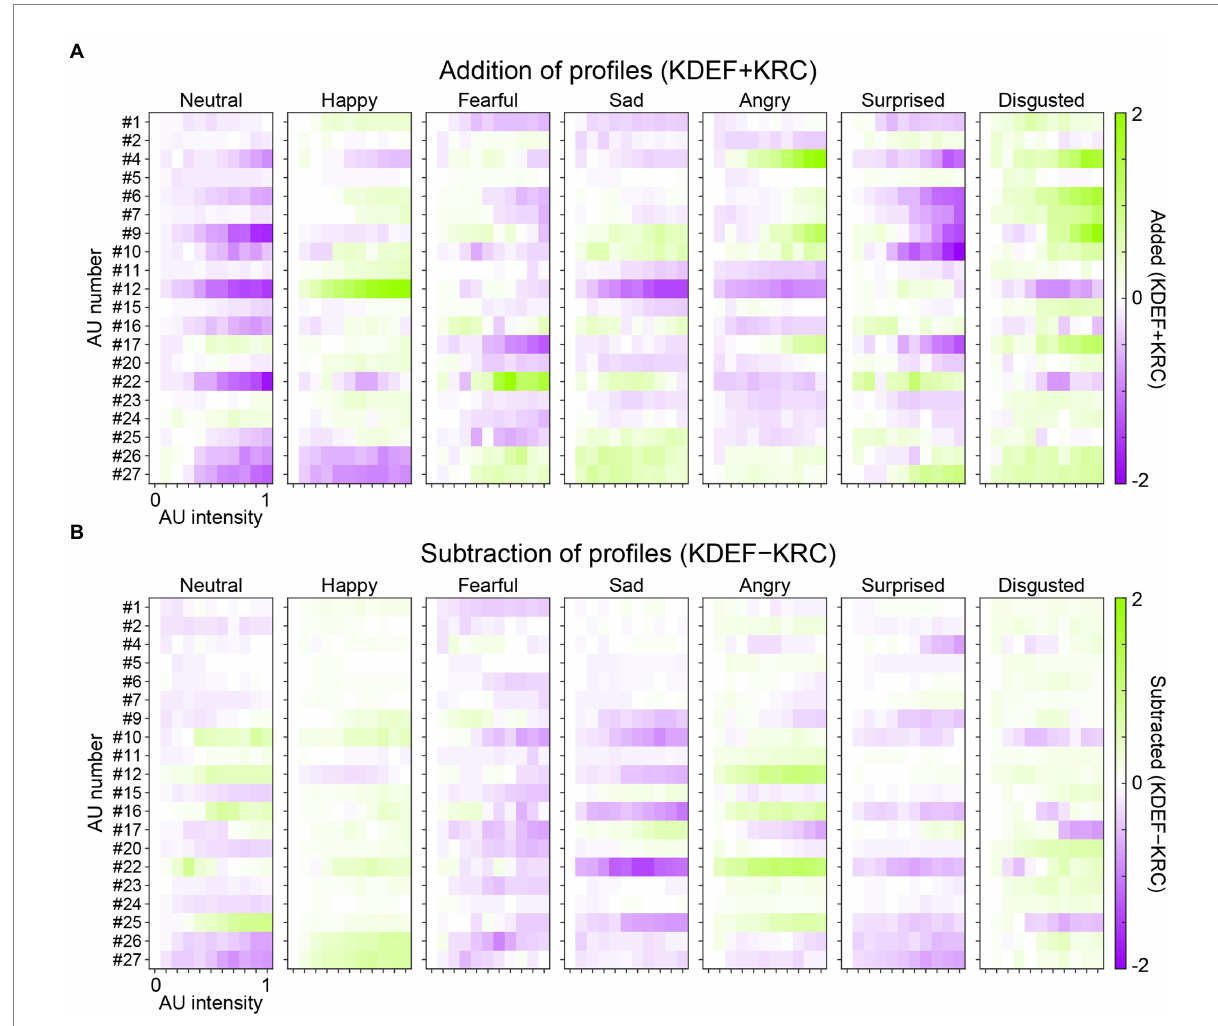
FIGURE 8 Similar and dissimilar tunings between the KDEF-trained and KRC-trained CNNs. For each of the seven computational units in the FC3 layer, the response profiles of the two groups of the CNNs are either added (KDEF + KRC) (A) or subtracted (KDEF − KRC) (B) . In A, positive and negative responses shared by the two groups are represented by darker green and purple colors, respectively. In B, green or purple indicates opposite tuning between the two groups. Green indicates positive responses in the KDEF-trained CNNs and negative responses in the KRC-trained CNNs. Purple indicates negative responses in the KDEF-trained CNNs and positive responses in the KRC-trained